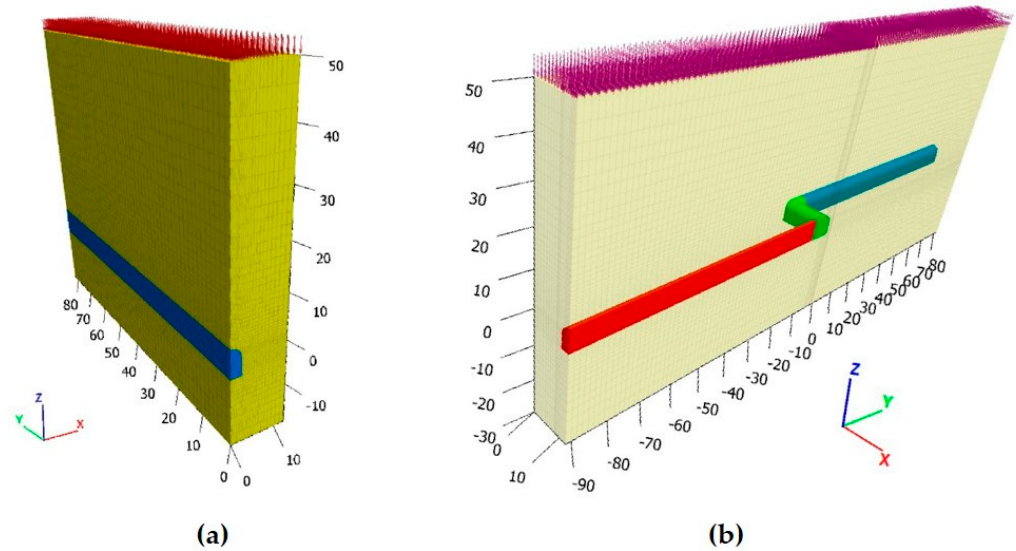
Figure 3. Geometry of the models of the network of tunnels: ( a ) transversal tunnels; ( b ) central tunnel-junction zone.